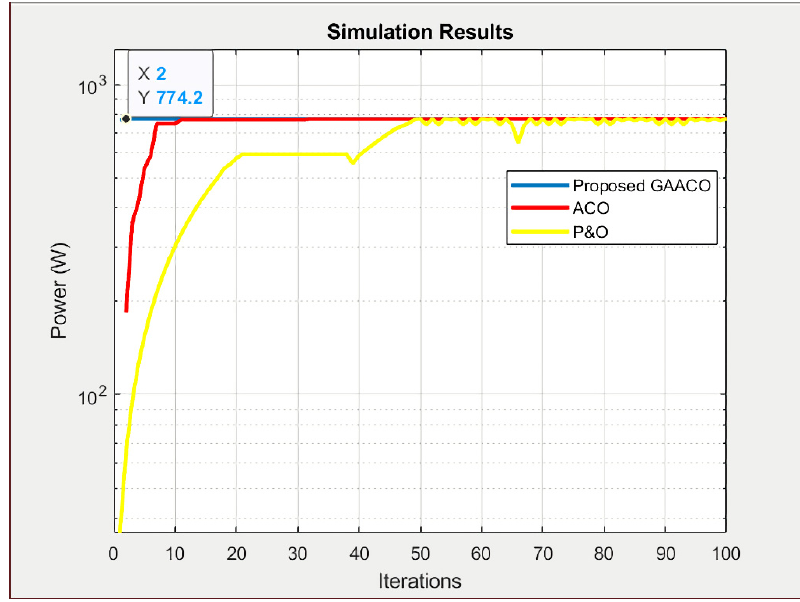
Figure 10. Simulation results of the proposed GA-ACO MPPT compared with P&O and conventional ACO MPPTs in Case 3.